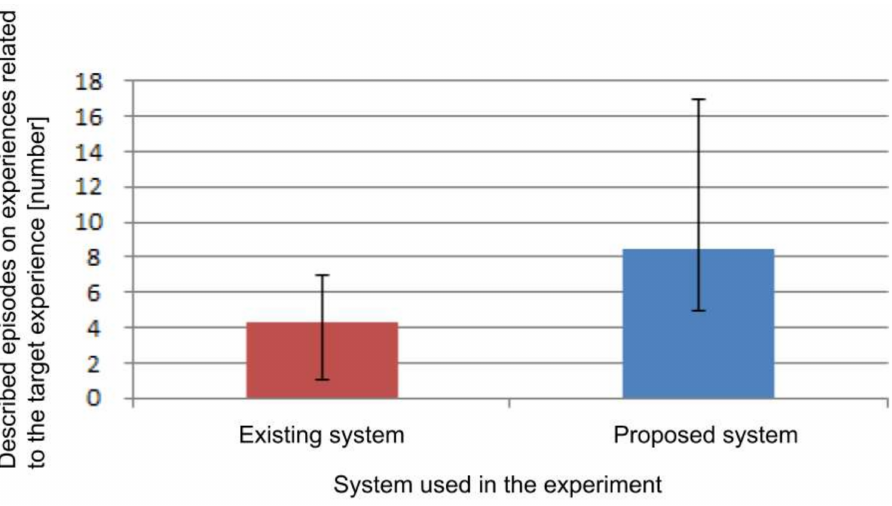
Figure 19. The average number of episodes including information on experiences related to the target experience in Experiment